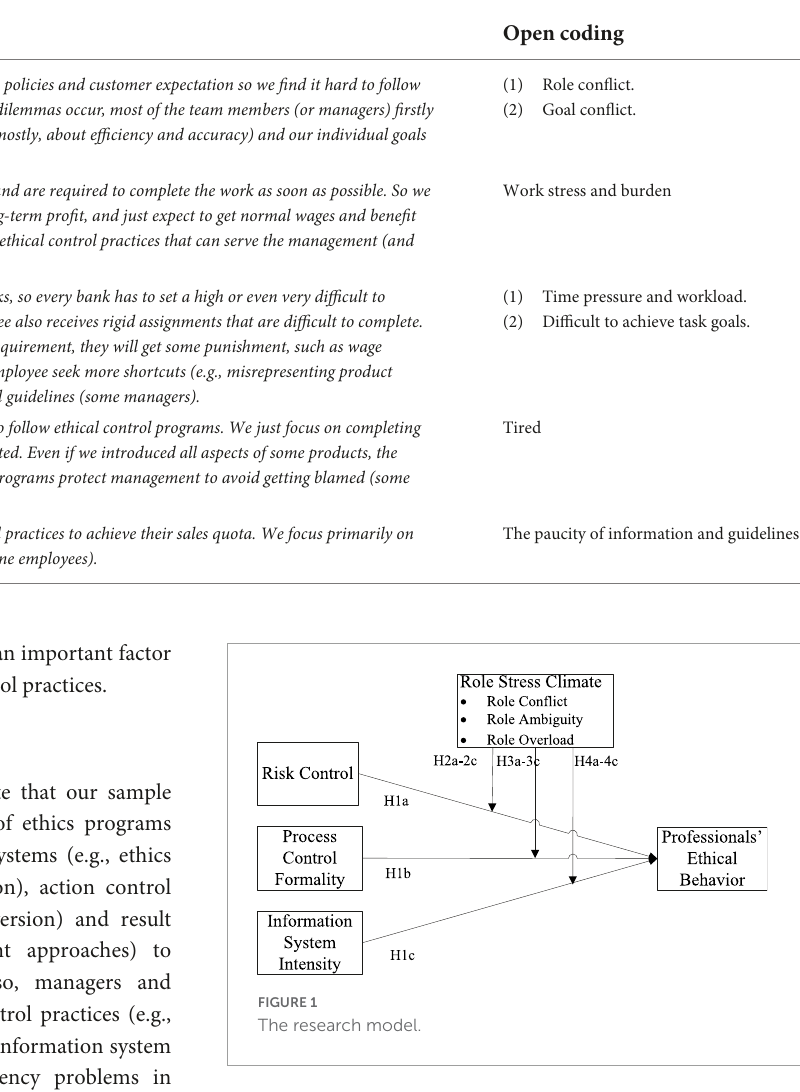
TABLE 4 Perceived main contextual factors impacting the effectiveness of control practices.